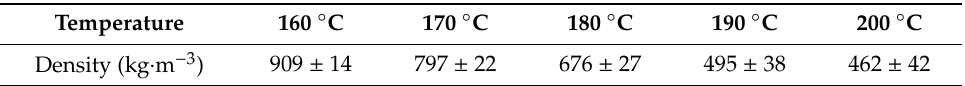
Table 1. Density of epoxy foam samples, reproduced from [99] with permission under open access license.